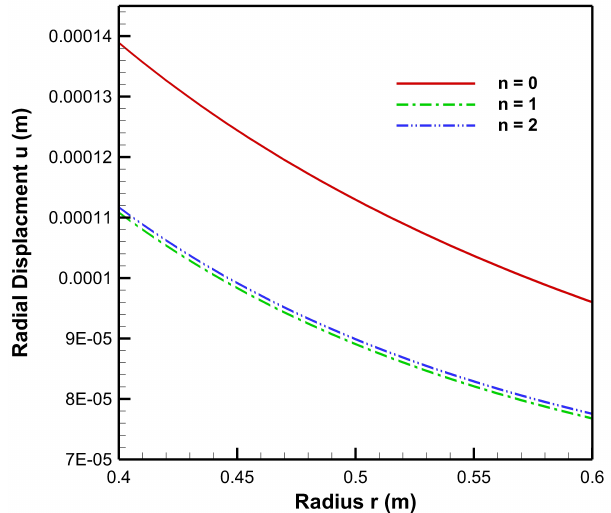
Figure 21. Iterative displacement σ θ in FGM cylinder at n = 0, n = 1 and n = 2 iterations under internal pressure, P a = 50 MPa and external pressure, P b = 20